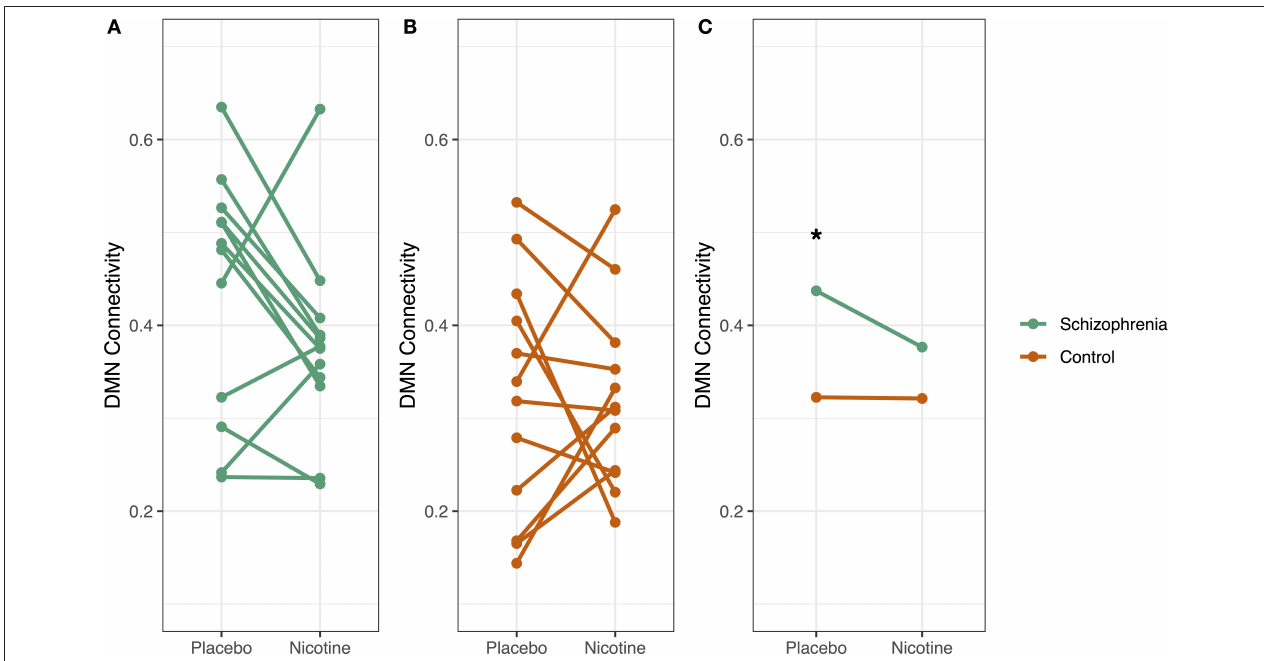
FIGURE 5 | Diagnosis-specific changes in DMN connectivity by drug condition. Whole default mode network (DMN) connectivity for each participant was measured at two timepoints: at placebo and at nicotine administration. In schizophrenia (A) , DMN connectivity decreased with nicotine administration, but this pattern was not evident in controls (B) . Subjects with schizophrenia had significantly higher DMN connectivity compared to controls in the placebo condition (* p < 0.05) but not with nicotine administration (C) . There was a trend-level interaction between diagnosis and smoking on DMN connectivity ( p = 0.09), where smoking and schizophrenia diagnosis both increased DMN